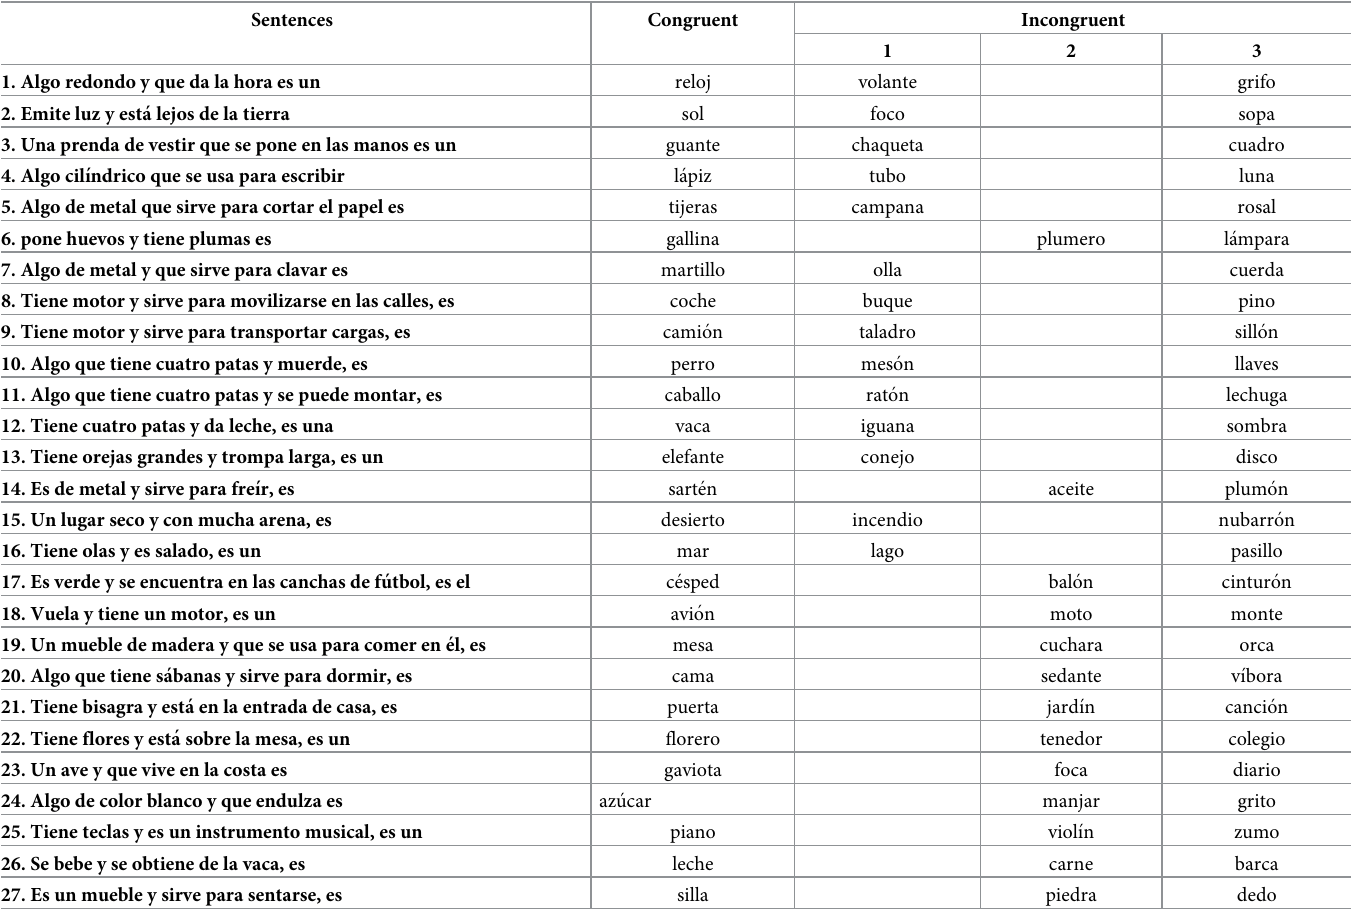
Table 2. List of sentences and endings employed in the semantic anomaly judgment task.